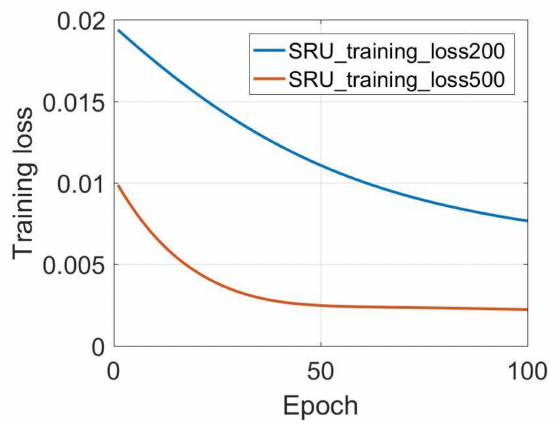
Figure 6. X-axis gyroscope training loss comparison.